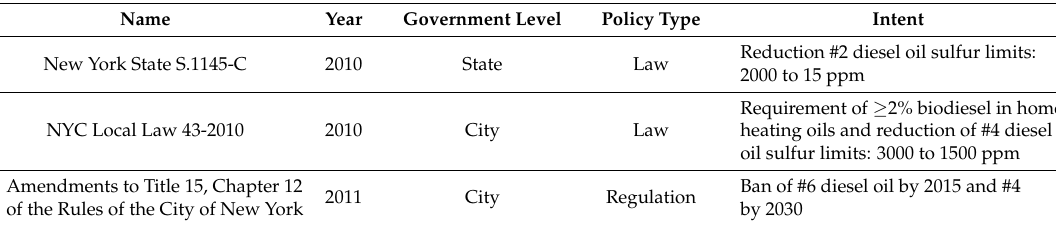
Table 2. Policies that comprise the NYC Clean Heat